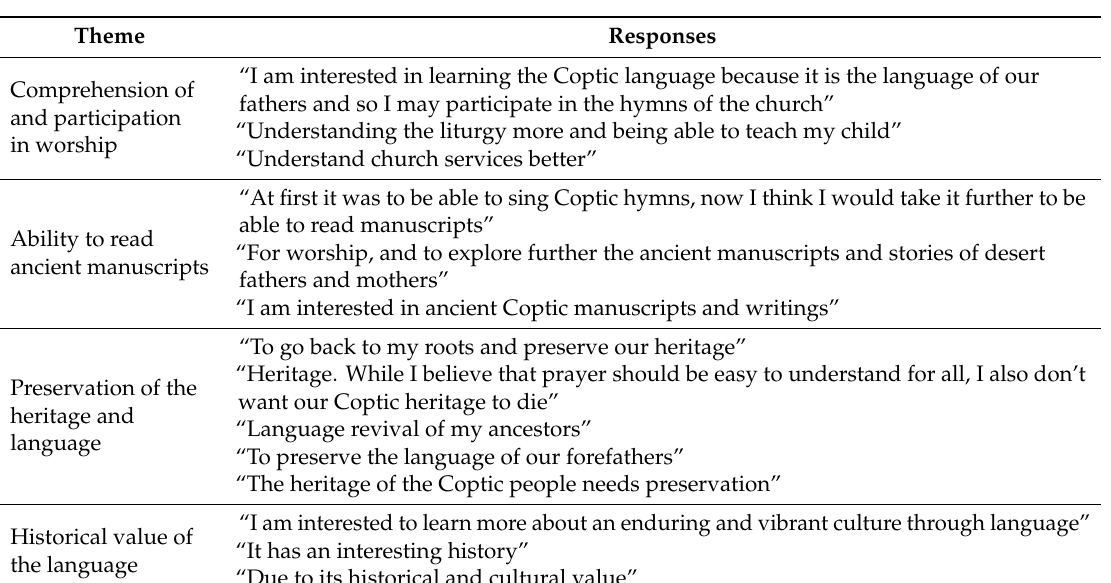
Table 2. Source of interest for learning the Coptic language.